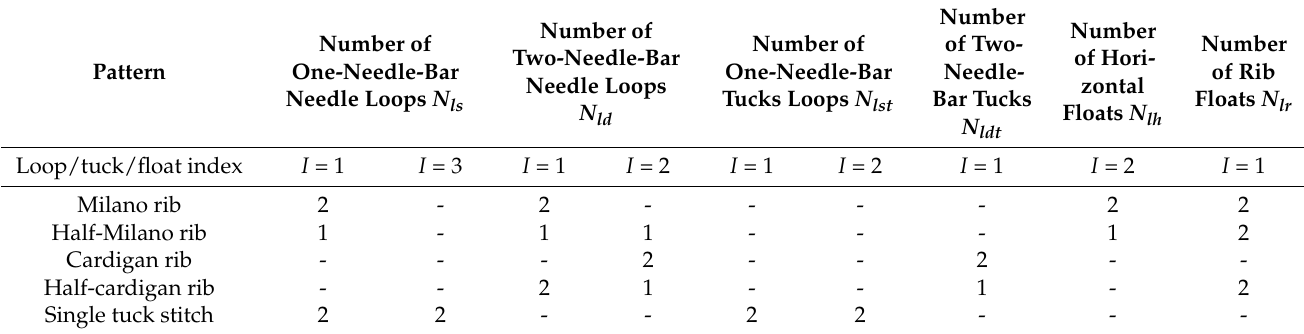
Table 2. Number of structural elements in pattern